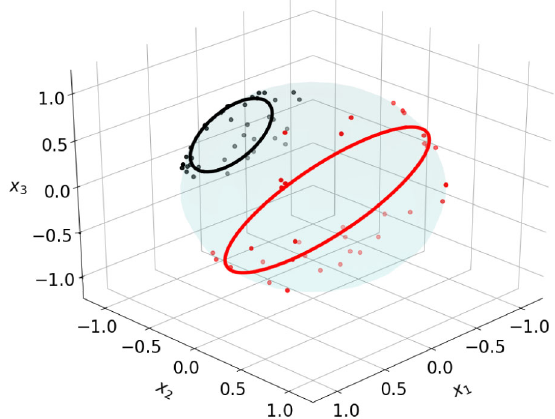
FIG. 8. Representation of the data and fits from Figs. 5 (black) and 6 (red) in the Cartesian coordinate system defined in Eq. (7). All points and curves lie on the unit